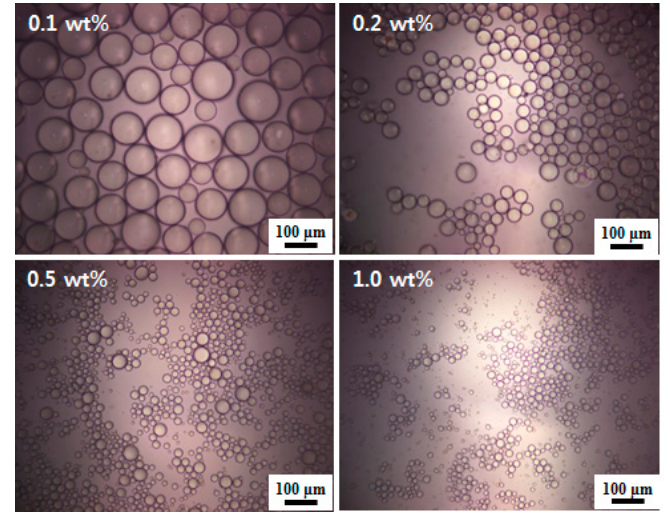
Figure 6. Optical micrographs of PMDA-ODA particle-stabilized n -hexadecane-in-water Pickering emulsions prepared at different particle concentrations (0.1 – 1.0 wt %).